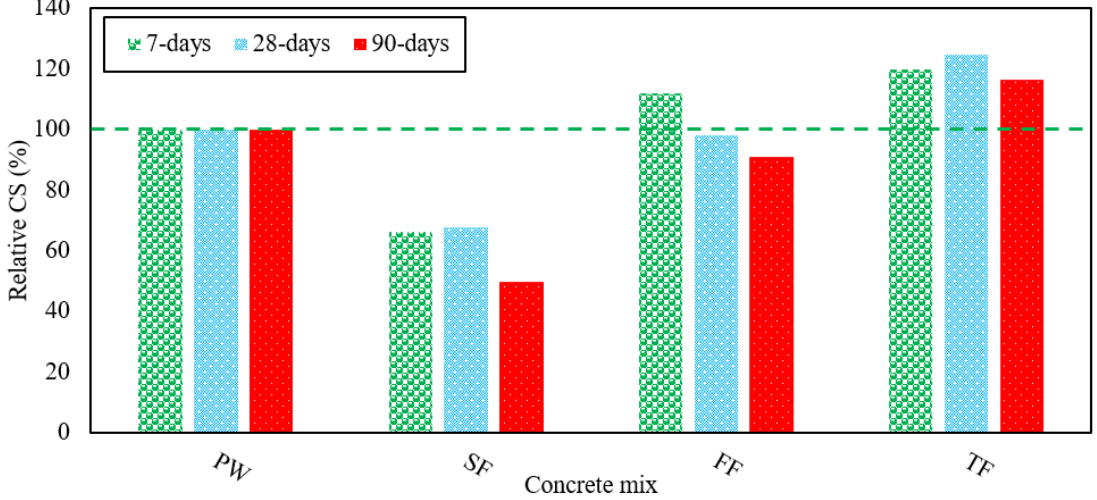
Figure 3. CS of various RAGC mixes relative to FW at 7, 28, and 90 days of testing.